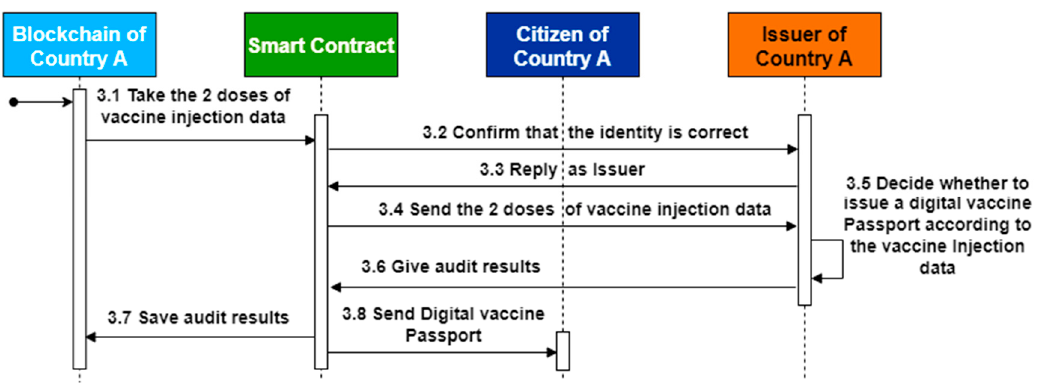
Figure 11. Sequence diagram of passport issuance of digital COVID-19 vaccine.